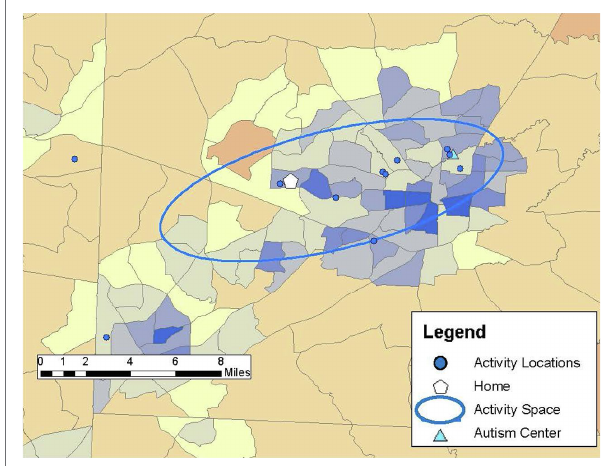
FIGURE 6 | Beth’s activity space (64.51 mi 2 ) showing the wide dispersion of community activity locations from the GPS study week, particularly to visit her family in another town on the weekend.